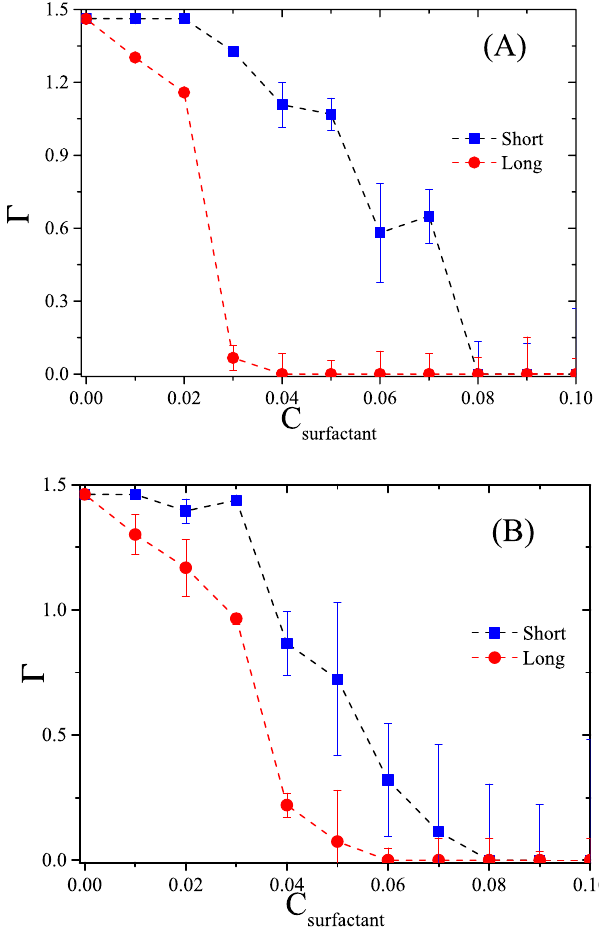
Figure 5. Desorption isotherms (Г) for heptane with nonionic and ionic surfactants as functions of surfactant concentration (C surfactant ). ( A ) The red line (circles) and blue line (squares) correspond to long and short nonionic surfactant chains, respectively. ( B ) Desorption isotherms with long (circles) and short (squares) ionic surfactants. Lines are only guides for the eye; all quantities are reported in reduced DPD